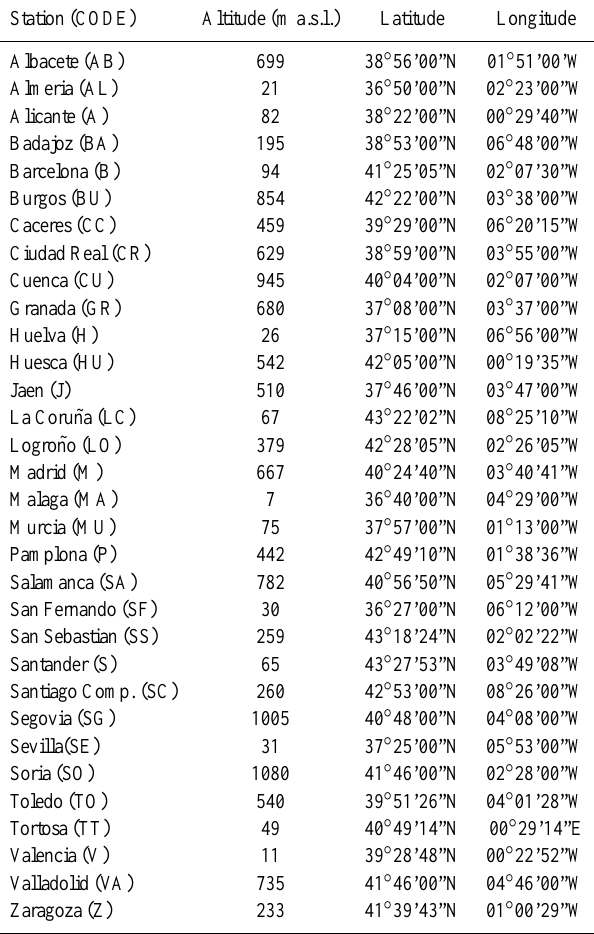
Table 1. Rainfall data series in Spain for the period